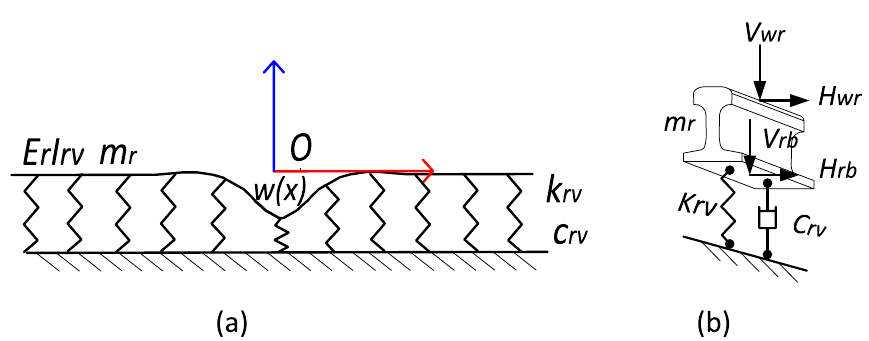
Fig. 17 Moving rail method (Jin and Pei 2016): a shape function of the rail; and b Moving rail